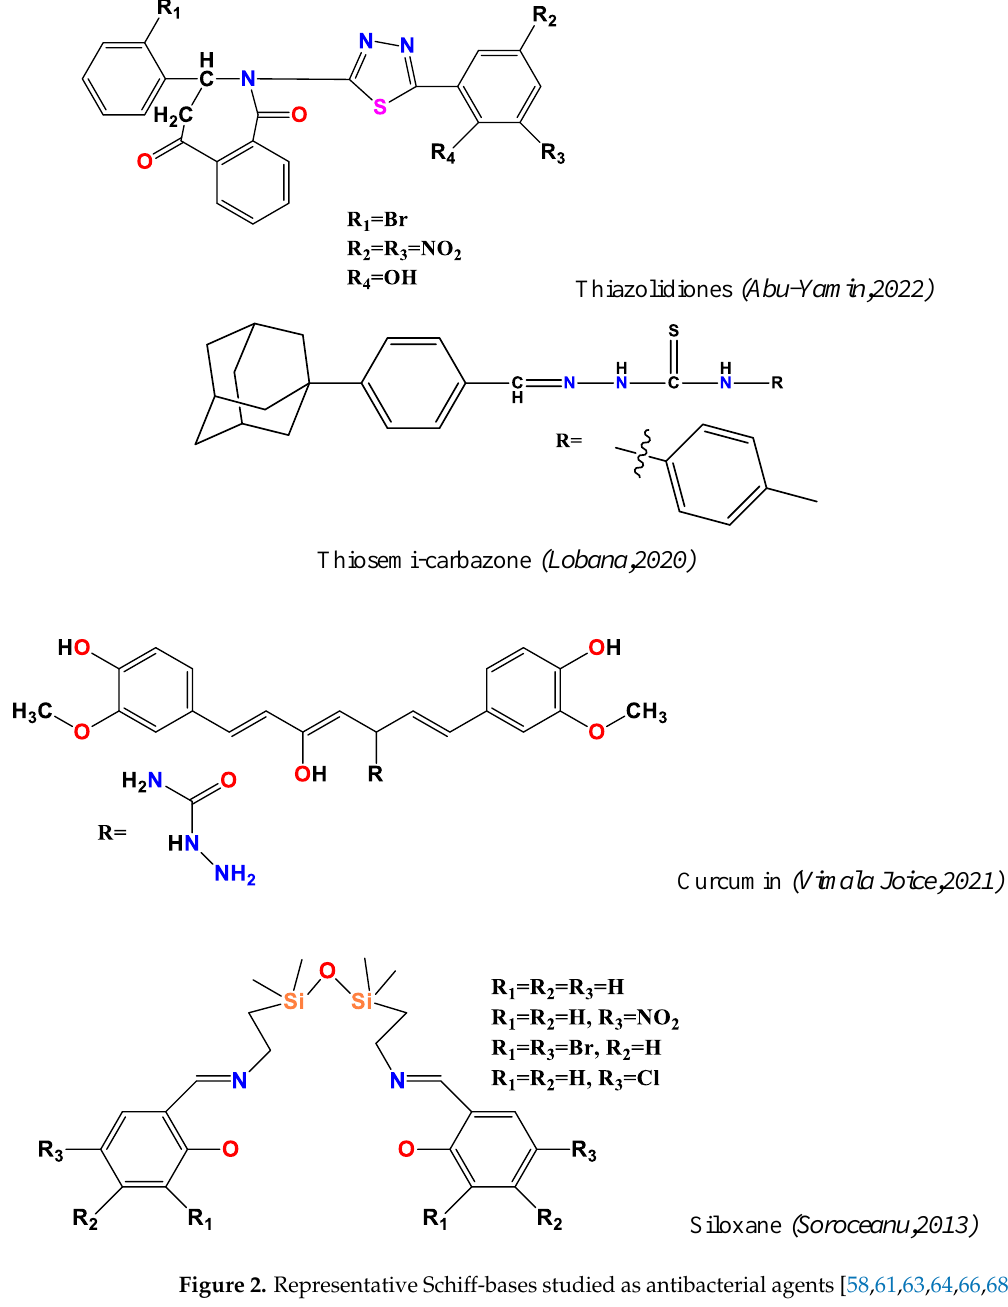
Figure 2. Representative Schiff-bases studied as antibacterial agents [61,63,64,66,68,70,74,72,75,95,58]. In another study, ligands, Schiff-bases type and their Cr(III), Fe(III), Mn(II), Cu(II), Zn(II), Ni(II), and Cd(II) metals, mononuclear chelate complexes have been obtained from 4-((1-5-acetyl-2,4-dihydroxyphenyl)ethylidene) ami- no)-1,5-dimethyl-2-phenyl-1H-pyrazol-3(2H)-one ligand, a tridentate ligand, were syn-